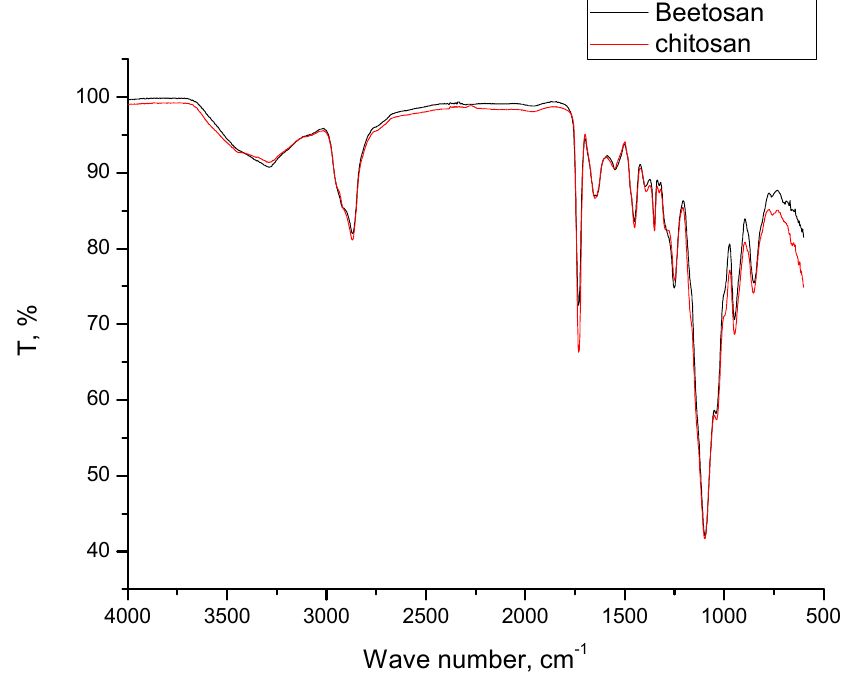
Figure 5. FT-IR spectra of hydrogels.